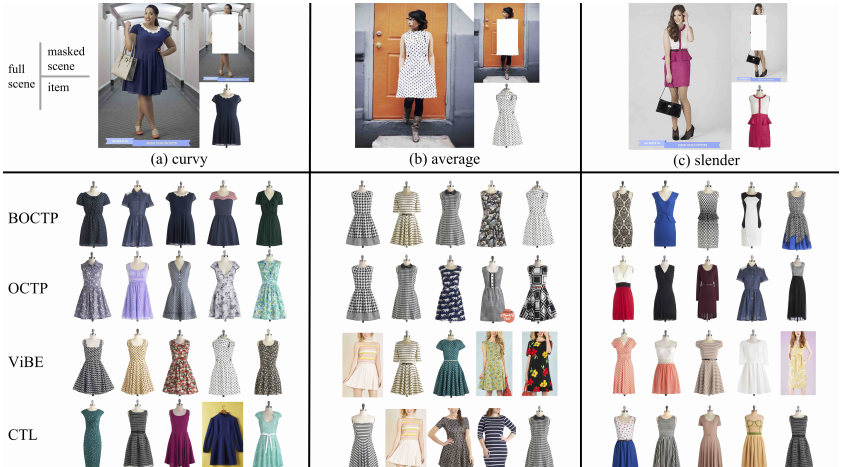
Figure 14. Visualizations of the top 5 recommendations of four methods on dresses for 3 subjects with typical body shapes. Each line is the top 1 to 5 (left to right) recommendation results of one method for 3 subjects,